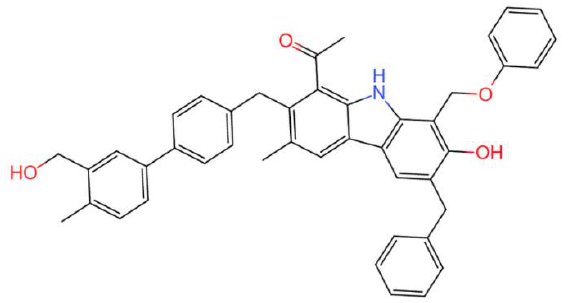
Figure 5. Simplified molecular structure of coal for quantum chemical calculations.